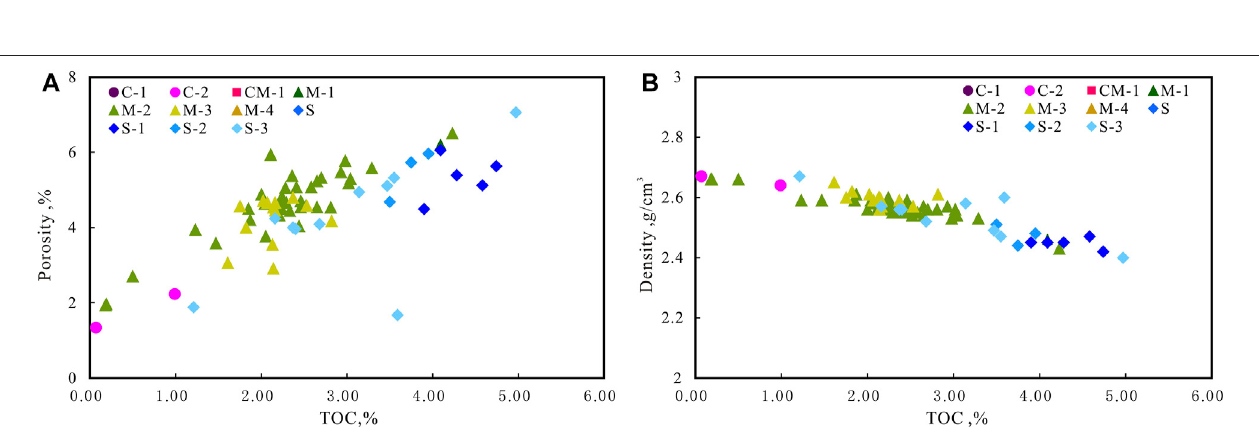
FIGURE 5 | TOC versus porosity (A) and density (B) of shale samples from Wufeng – Longmaxi Formation in the L203 well area.